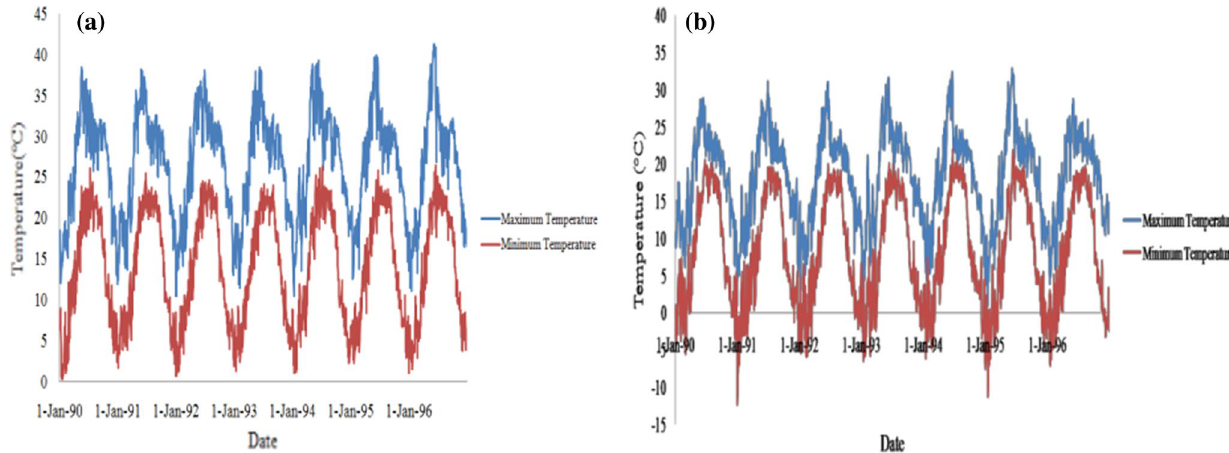
Fig. 4 Variation of maximum and minimum temperatures from a IMD, b ERA-Interim of Beas basin